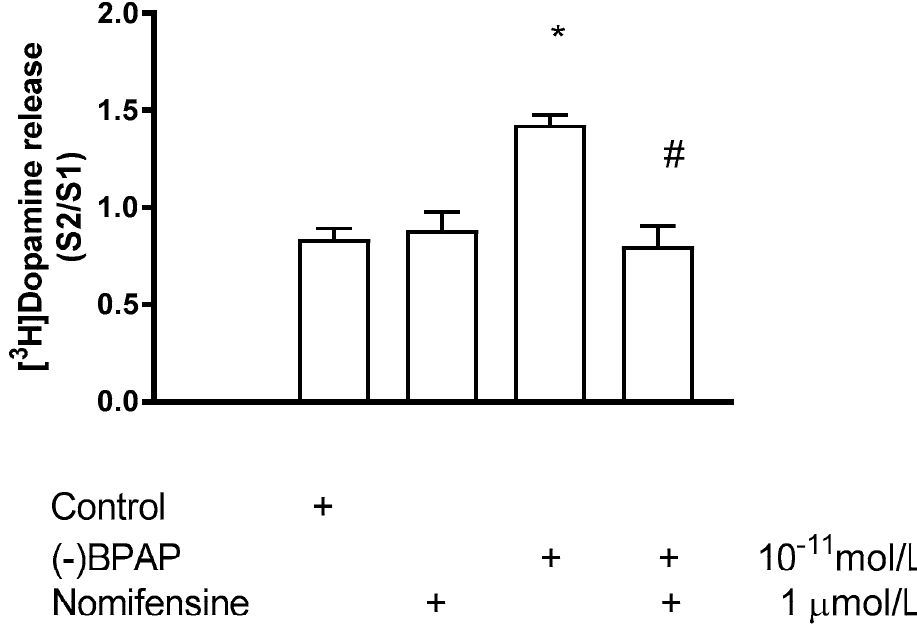
Figure 9. Effect of nomifensine on ( − )BPAP-induced [ 3 H]dopamine release in rat striatum. For the experimental procedure, see Figure 2A. ( − )BPAP was added to striatal slices from fraction 8 in a concentration of either 10 − 11 mol/L in the presence and absence of nomifensine. When used, nomifen- sine was added to striatal slices from fraction 1 in a concentration of 1 µmol/L and drugs were main- tained throughout the experiment. One-way ANOVA followed by the Dunnett’s test, F(3,12) = 4.784, p = 0.020, control vs. ( − )BPAP effect * p < 0.05. Student t -statistics for two-means, ( − )BPAP vs.